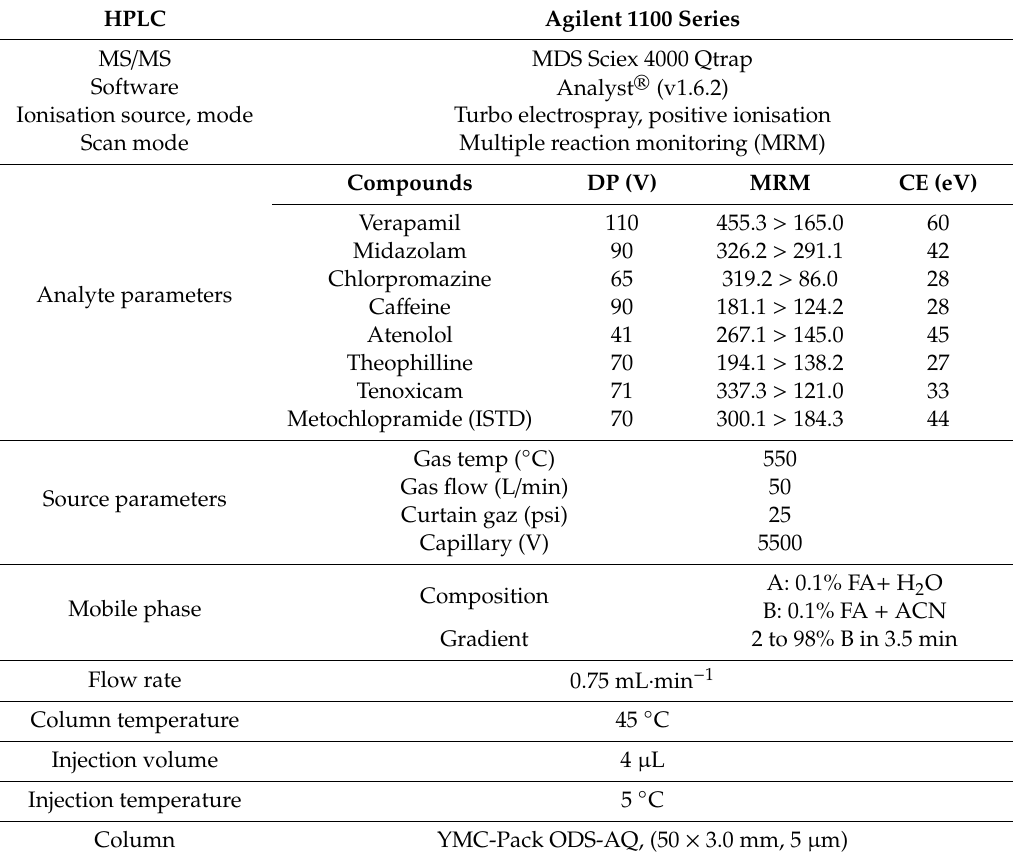
Table 2. Summary of mass spectrometry